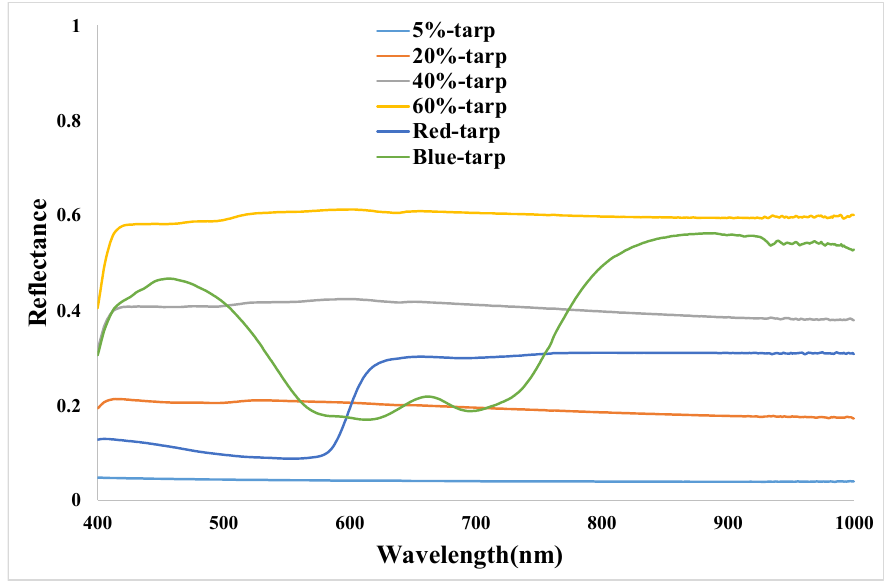
Figure 7. Spectral reflectance measurement data of calibration tarps.